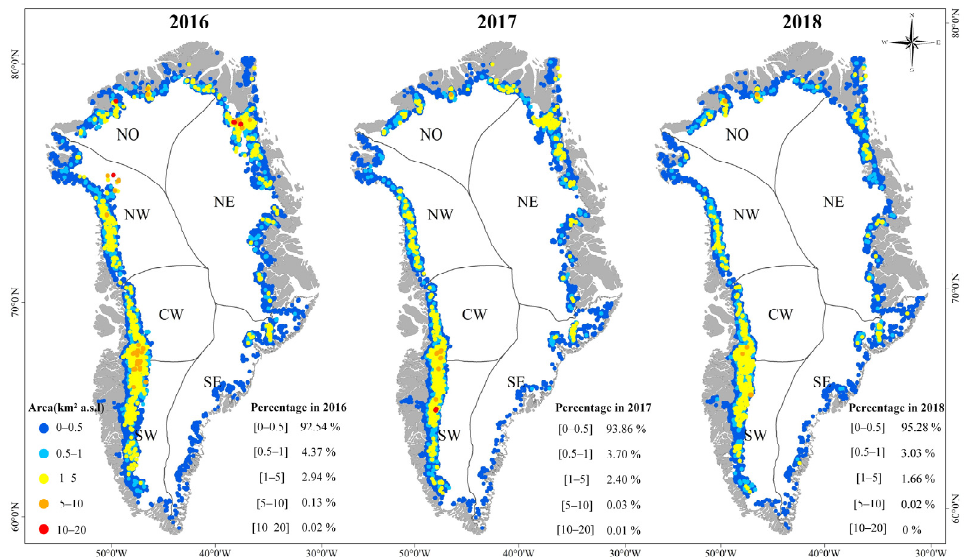
Figure 5. Temporal and spatial distribution of SGLs in Greenland during the melt seasons from 2016 to 2018. The various types of lakes are labeled as “0–0.5”, “0.5–1”, “1–5”, “5–10”, and “10–20” which was used to indicate the percentage of the number of each type of SGLs in each year).